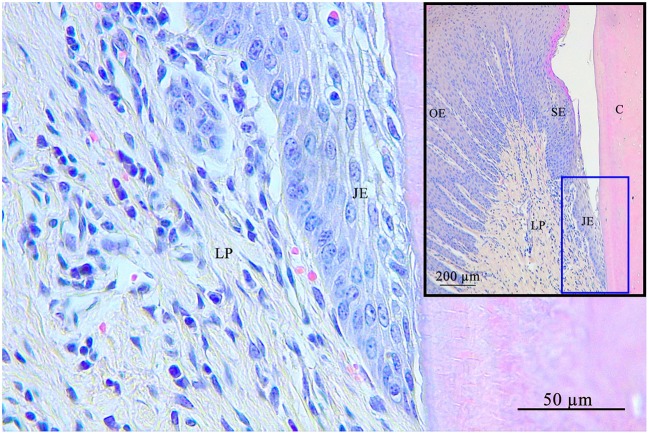
Junctional epithelium (blue square) at the bottom of the gingival sulcus. The junctional epithelium is the connection of the gingiva with the tooth. C, cementum; JE, junctional epithelium; SE, sulcular epithelium; OE, oral epithelium; LP, lamina propria.